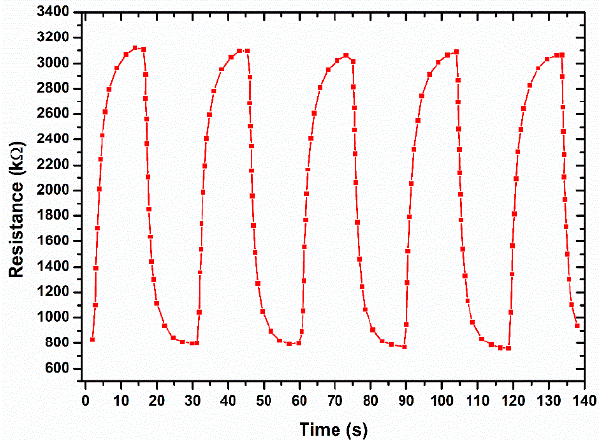
Figure 8. Response time of the temperature sensor at heating and cooling cycles.